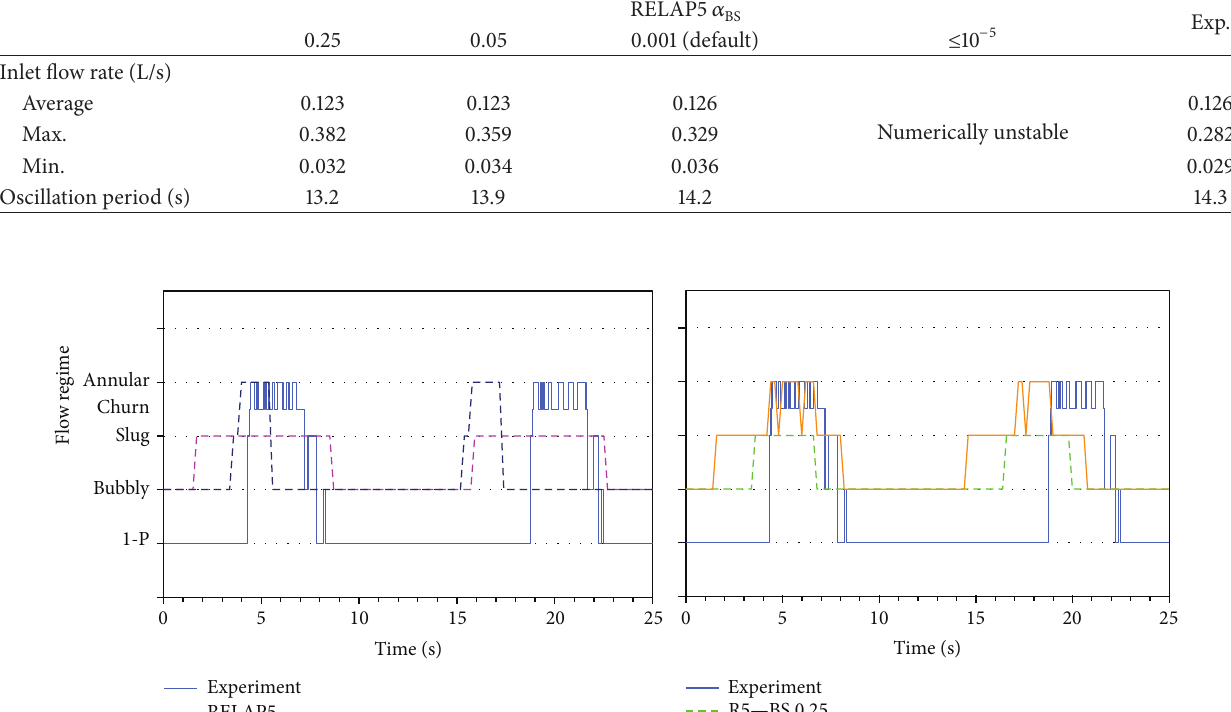
Table 7: Inlet flow rate and oscillation period from calculations with varying bubbly-to-slug transition boundary and the experiment.